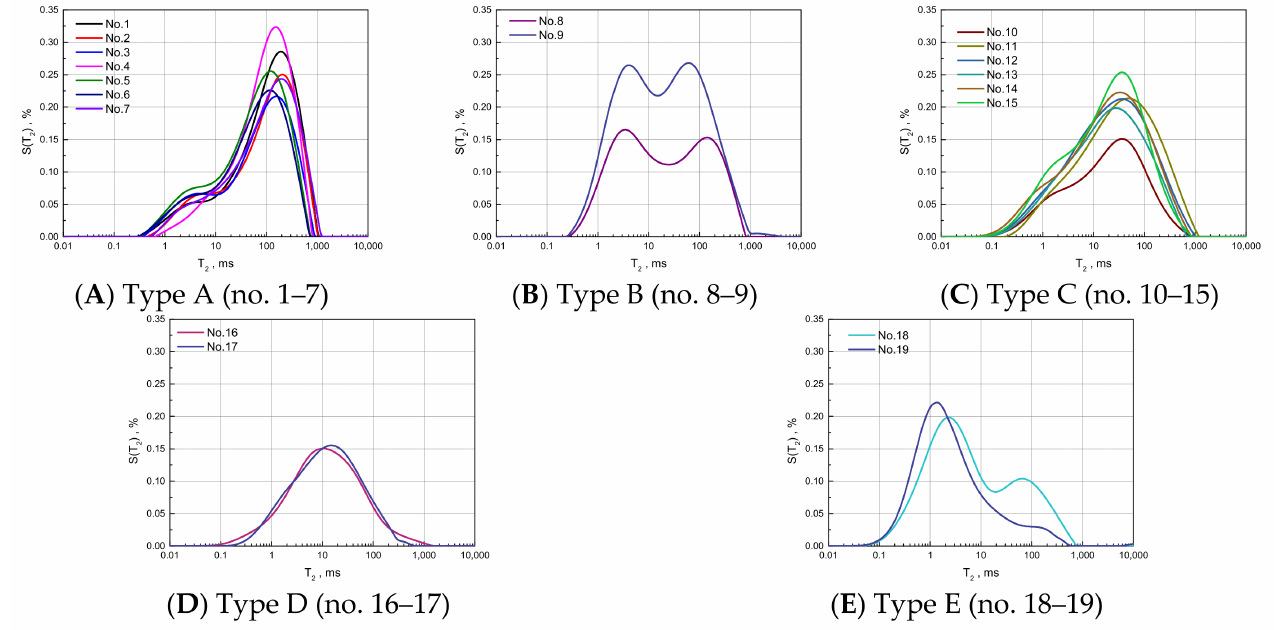
Figure 2. T 2 curves of 19 rock samples and pore structure